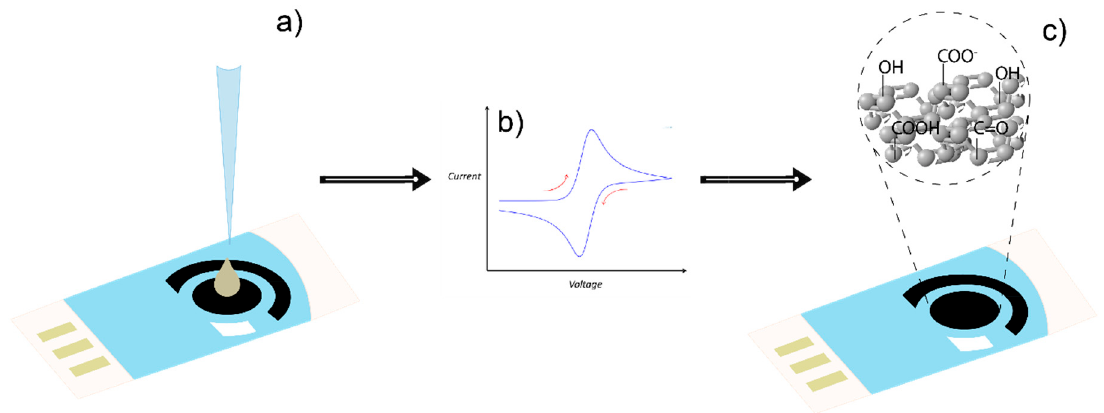
Figure 1. Electrochemical oxidation of the CNT surface on SPE. ( a ) Application of a H 2 SO 4 drop on the CNT, ( b ) cyclic voltammetry for electrochemical oxidation, and ( c ) oxidized surface of the CNT on the SPE.